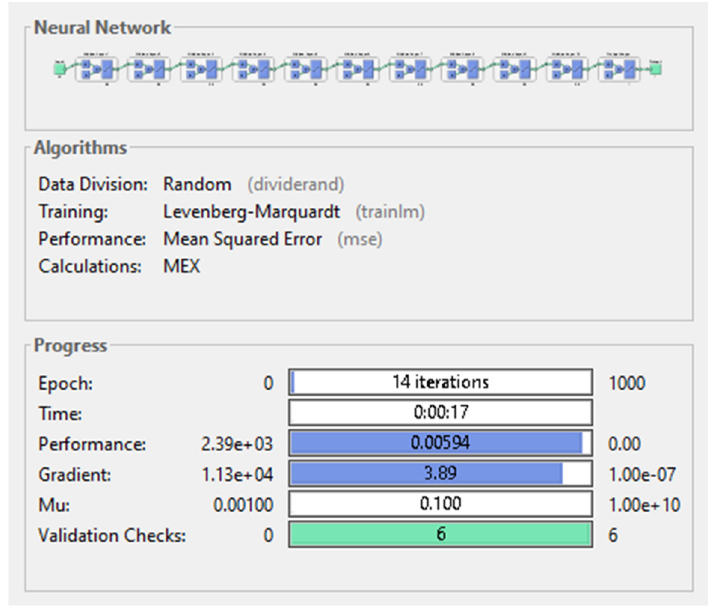
Figure 11. Neural network with 10 hidden-layers and 20 neurons on each hidden-layer. Examining the performance plot of the network (Figure 12), it can be observed that no over or underfitting has occurred during training and the minimum MSE was approxi- mately reached only after the 4th epoch.